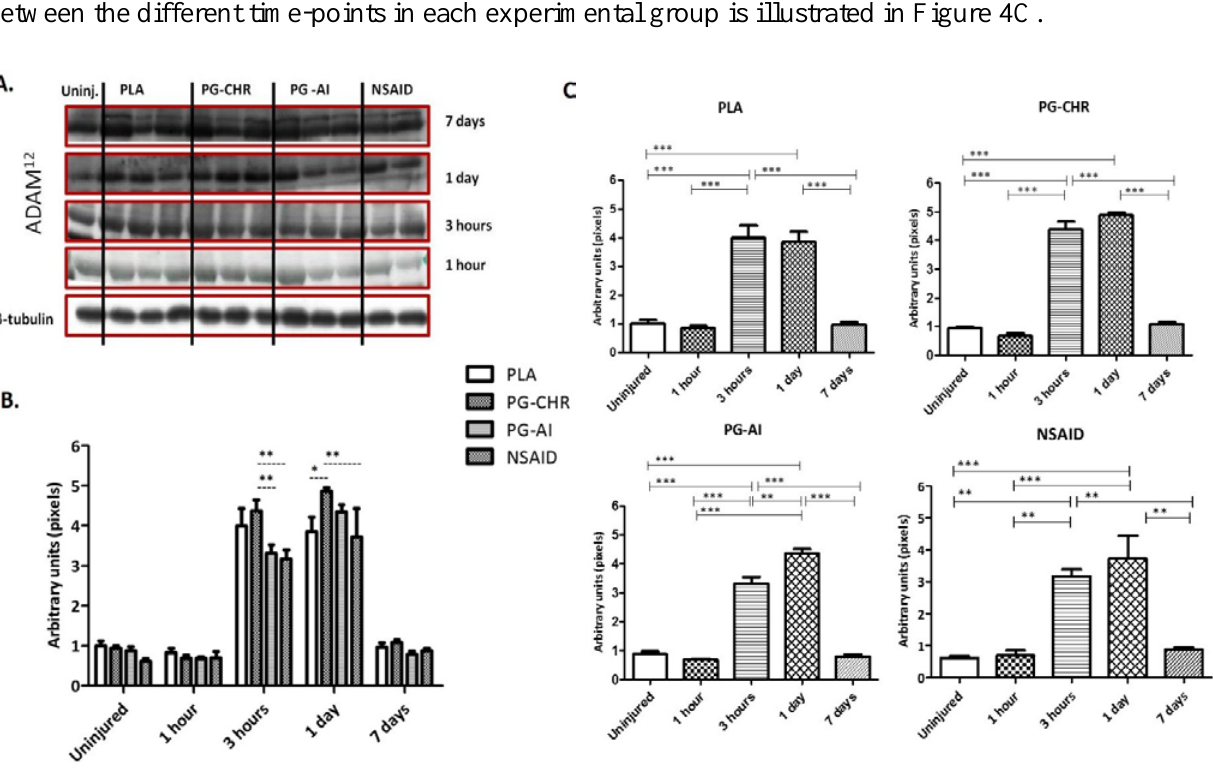
Figure 4. ADAM 12 expression in skeletal muscle following a contusion injury. ( A ) Representative Western blots. Top 4 bands represent ADAM 12 expression and the bottom bands represent β-tubulin expression (confirm equal loading of the protein); ( B ) Combined data for all the different groups; ( C ) Statistical differences observed between the different time-points in each experimental group. Values are expressed relative to the uninjured values. The data are expressed as mean ± SEM; Analysis by two-way ANOVA; n = 5 per time-point/per group; Differences over time are indicated by solid lines and broken black lines indicate group differences at specific time points; Significance: *** p < 0.0001, ** p < 0.001 and * p <